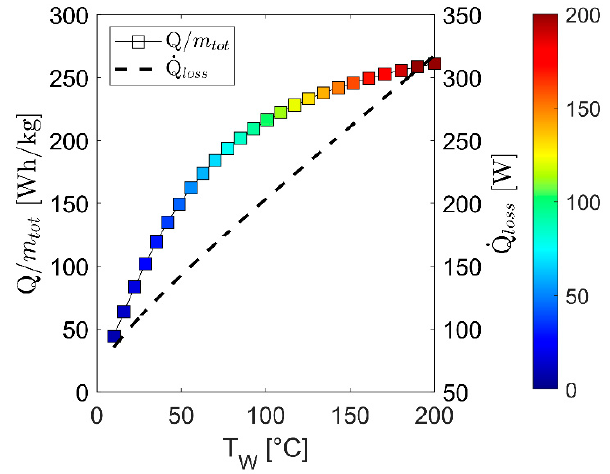
. Q loss ) as a function of the permitted